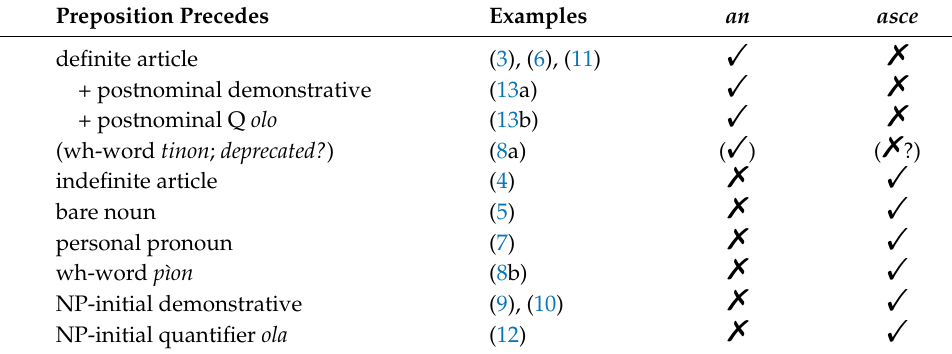
Table 2. Contexts for the use of an and asce